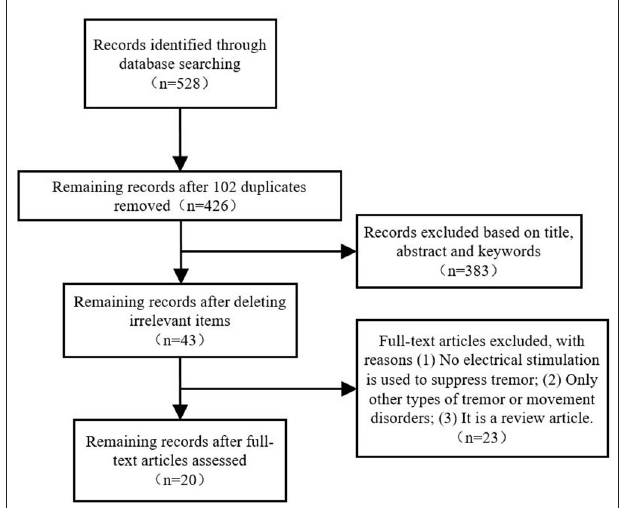
FIGURE 1 | PRISMA flow chart of the screening and exclusion